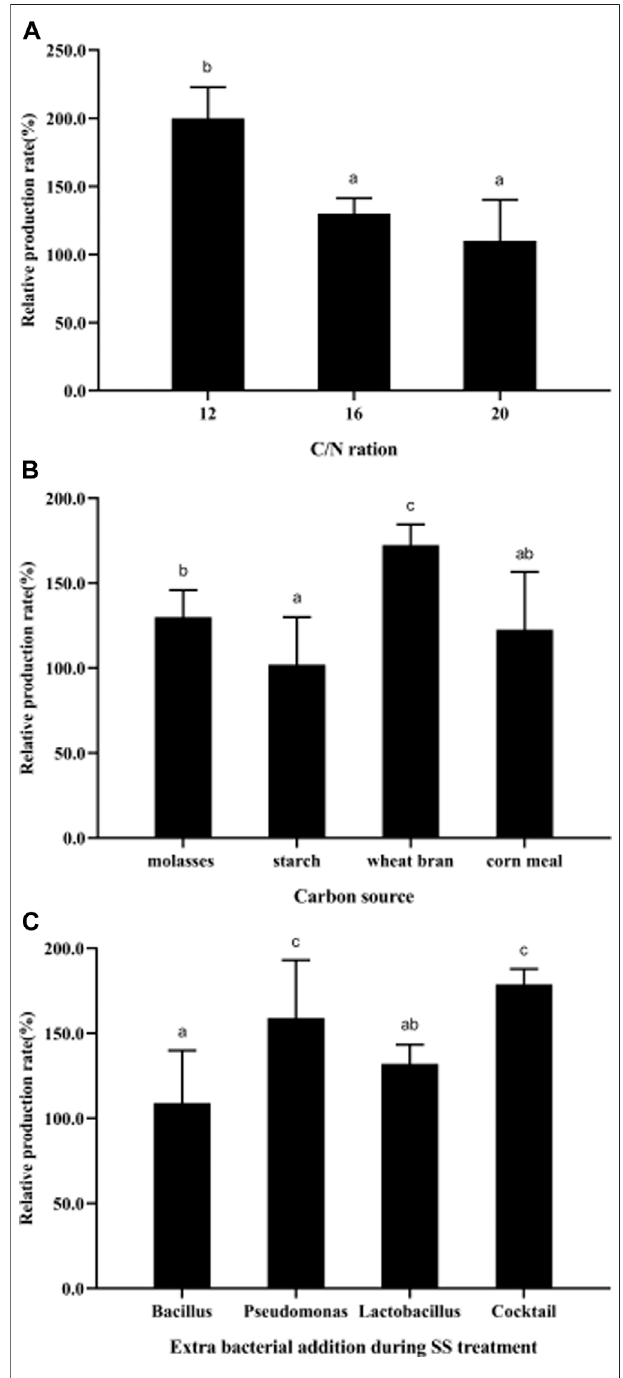
FIGURE 6 | Parametric optimization for high-yield PHB production during SS treatment. (A) , C/N ration; (B) , carbon sources; (C) , probiotics widely used in practical aquaculture.All the dataare presented asmean ± SE. Valuesmarkedwithdifferentsmalllettersindicatessigni fi cantdifferences among groups ( p < 0.05). The strain information used in this study is: Bacillus , Bacillus subtilis ; Pseudomonas , Pseudomonas putida ; Cocktail, cocktail of Pseudomonas and Lactobacillus .